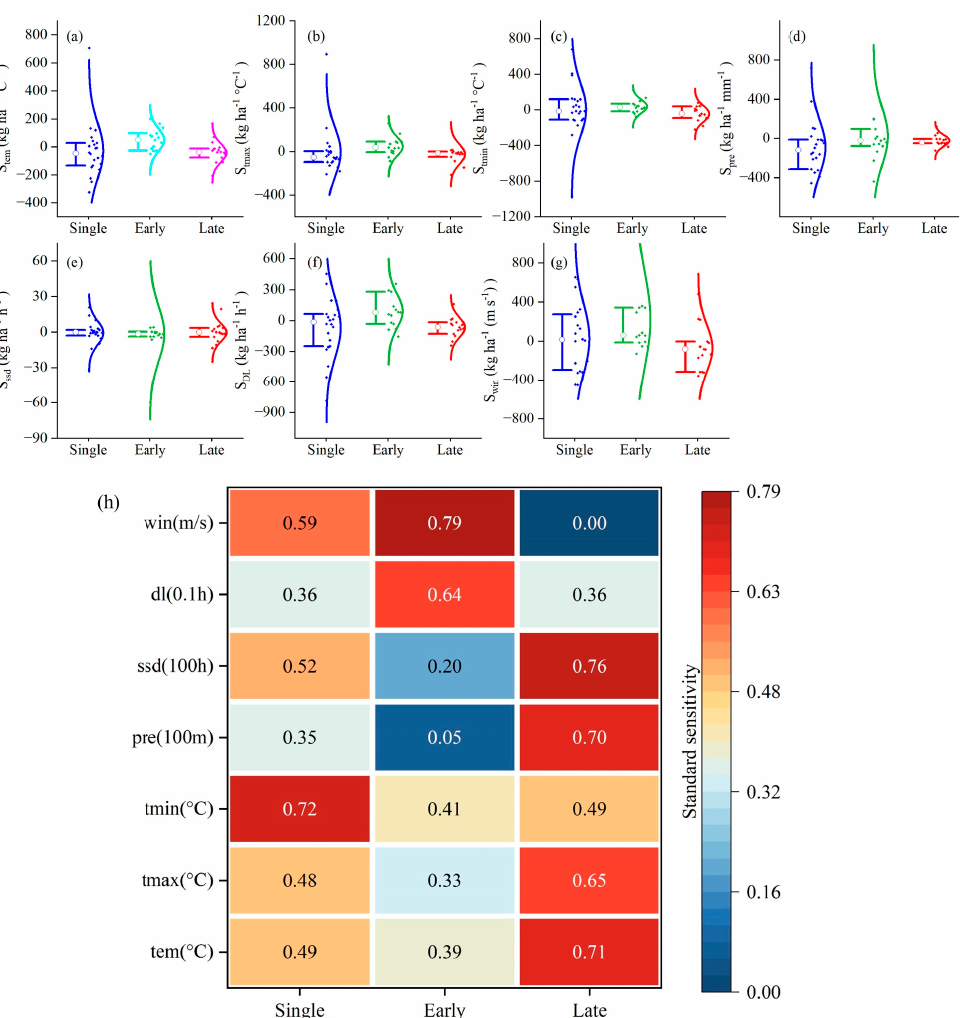
Figure 3. Sensitivity of rice yield to climatic factors ( a – g ) and relative importance ( h ). ( a – g ) Sensitivity of rice yield to mean temperature, maximum temperature, minimum temperature, precipitation, sunshine duration, photoperiod, and wind speed,